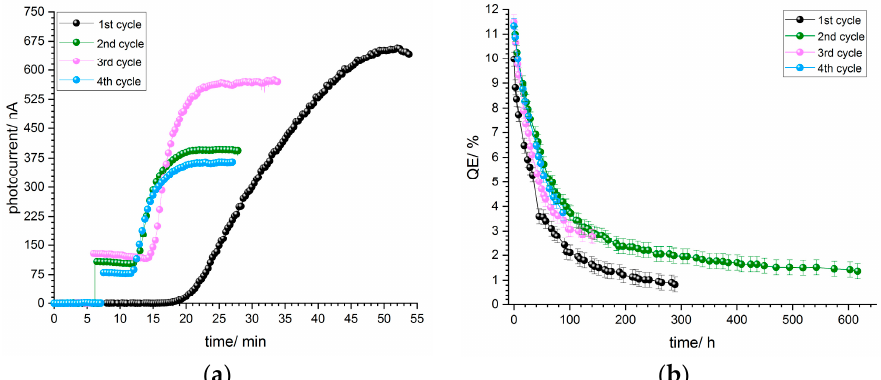
Figure 6. ( a ) Photocurrent curves of p-GaN (sample A5), which was thermally cleaned at 500 °C and activated with cesium for four cycles, and ( b ) QE decay curves of the same p-GaN:Cs photocathode after activation.